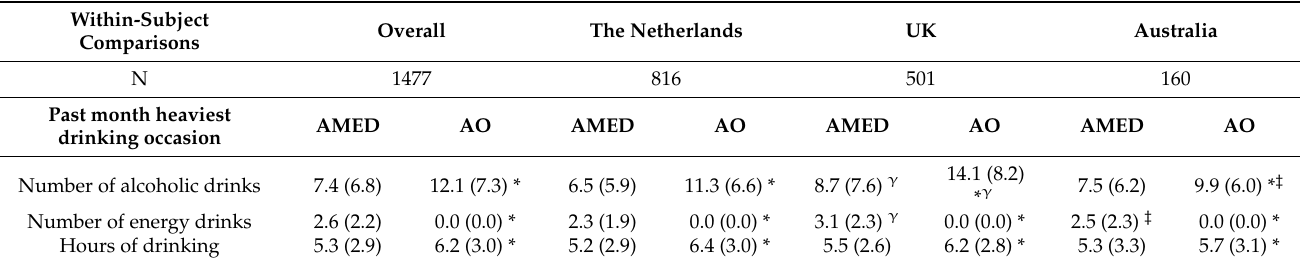
Table 5. Alcohol consumption of AMED consumers on their past month heaviest AMED and AO occasion (within-subject